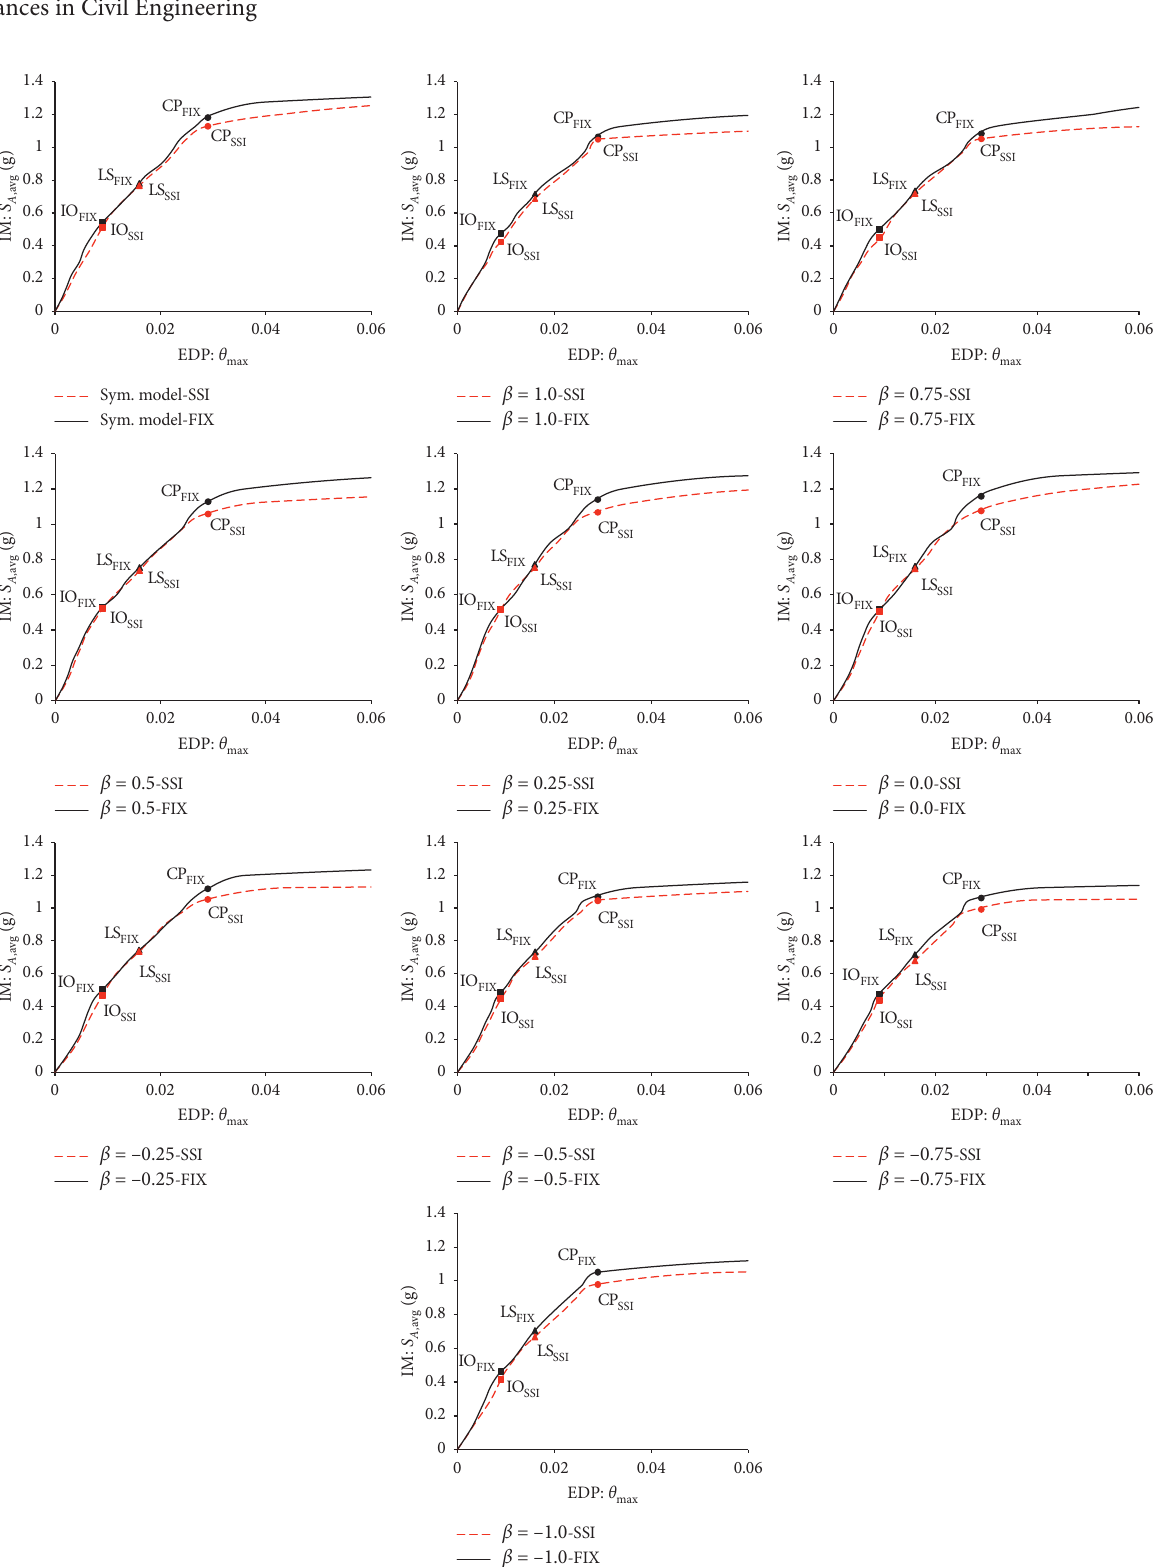
Figure 11: The median IDA curve of various models with fixed base and flexible